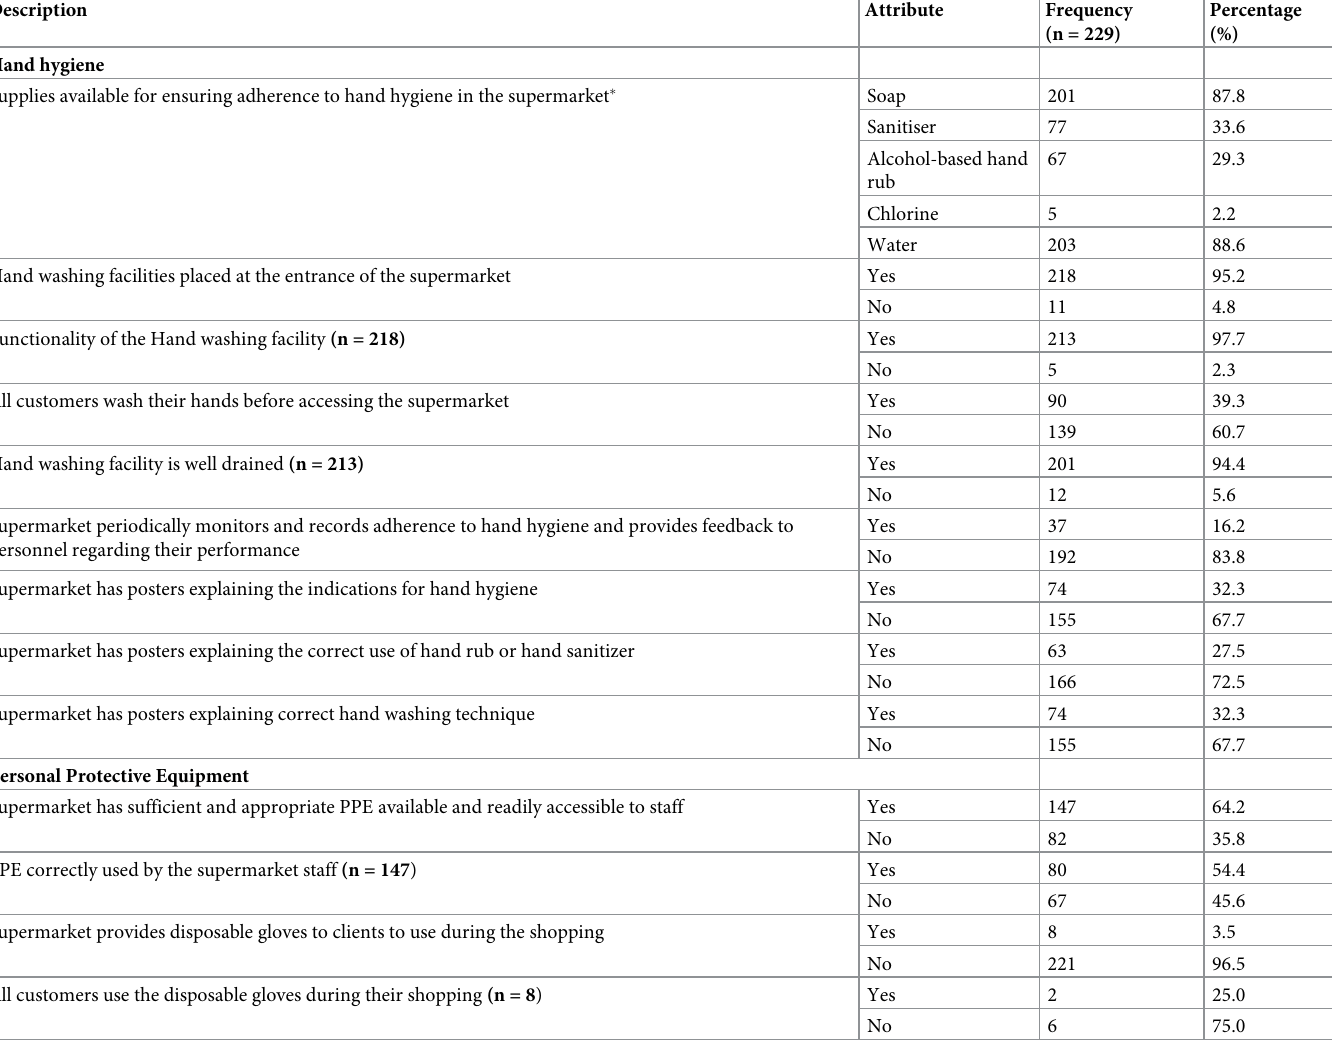
Table 3. Hand hygiene and use of personal protective equipment in supermarkets in Kampala Capital City and Mukono Municipality, Uganda.